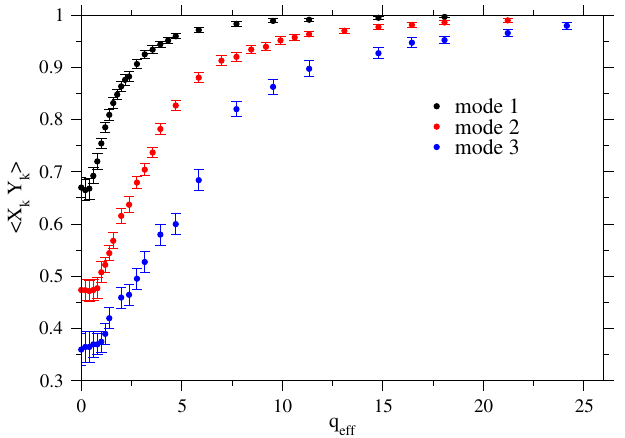
FIG. 5. 3D-G bunch. The overlap h X k Y k i [see Eq. (32)] in the longitudinal phase space of the mode k with the space charge harmonic k for k ¼ 1 ; 2 ; 3 . At small q the overlap increases eff > ≈ 4 k the increase of rapidly with increasing q . For q eff eff h X Y i with q saturates indicating the transition to the strong k k eff space charge transverse bunch distribution. The value of 2.4 is character- istic of transverse Gaussian beams.